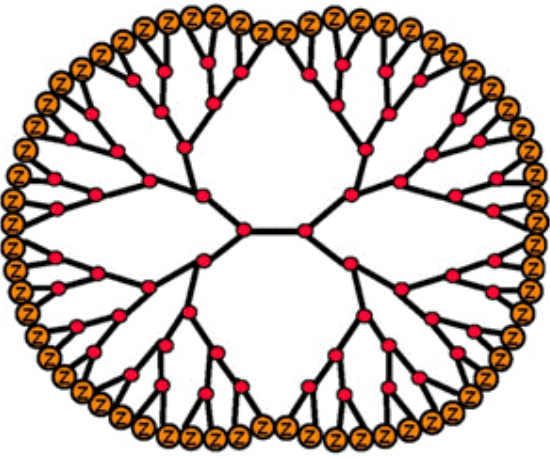
FIGURE 4. Schematic representation of 1,2- diaminoethane-cored generation 4.0